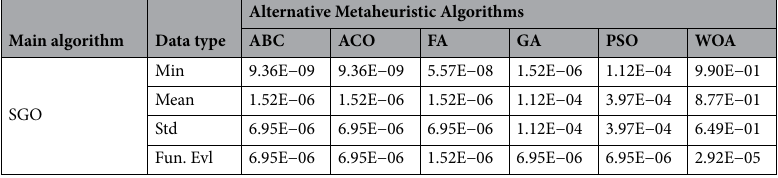
Table 5. The KS test outcomes (p-values) of different metaheuristic